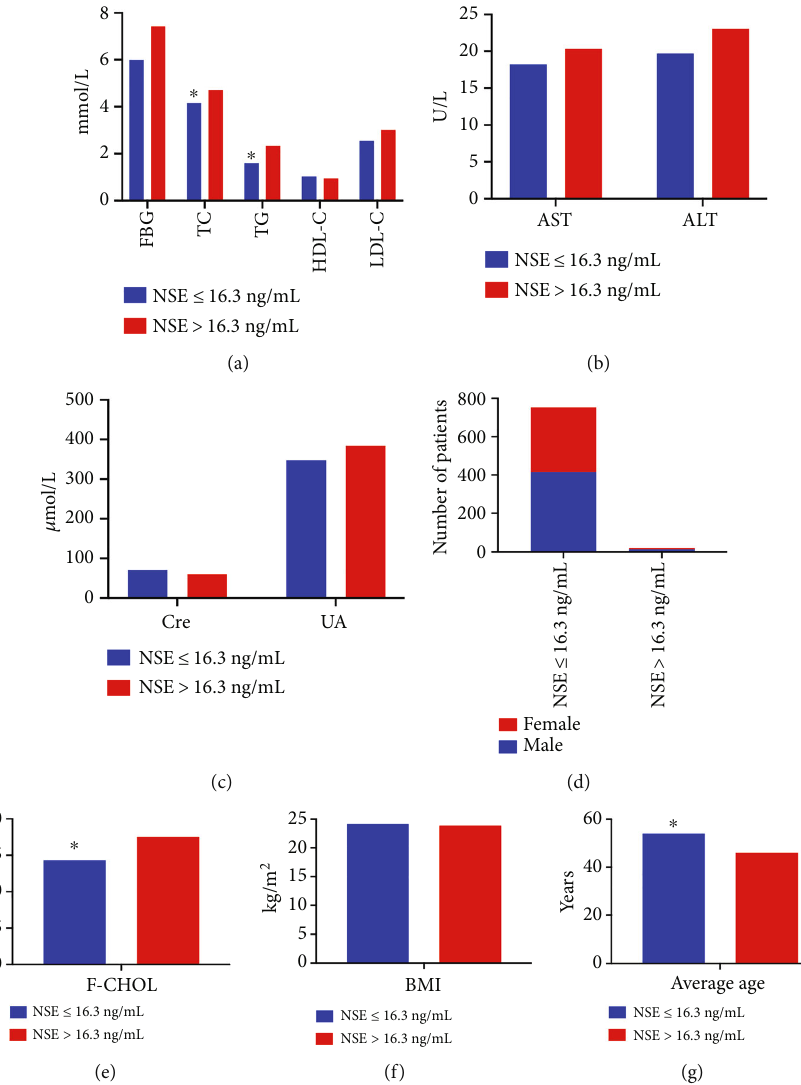
Figure 6: Comparison of di ff erent indicators between the NSE ≤ 16 : 3 ng/mL and NSE > 16 : 3ng/mL groups. (a) Comparison of levels of FBG, TC, TG, HDL-C, and LDL-C between the two groups. Compared with the NSE > 16 : 3ng/mL group, the levels of TG and TC were signi fi cantly lower in NSE ≤ 16 : 3 ng/mL group. (b) Comparison of AST and ALT levels between the groups. (c) Comparison of Cre and UA levels between the groups. (d) Comparison of the number of male and female patients between the groups. (e) The levels of F- CHOL were signi fi cantly lower in NSE ≤ 16 : 3ng/mL group. (f) Comparison of BMI of patients between the groups. (g) The average age of patients in NSE ≤ 16 : 3 ng/mL group was signi fi cantly higher than in NSE > 16 : 3ng/mL